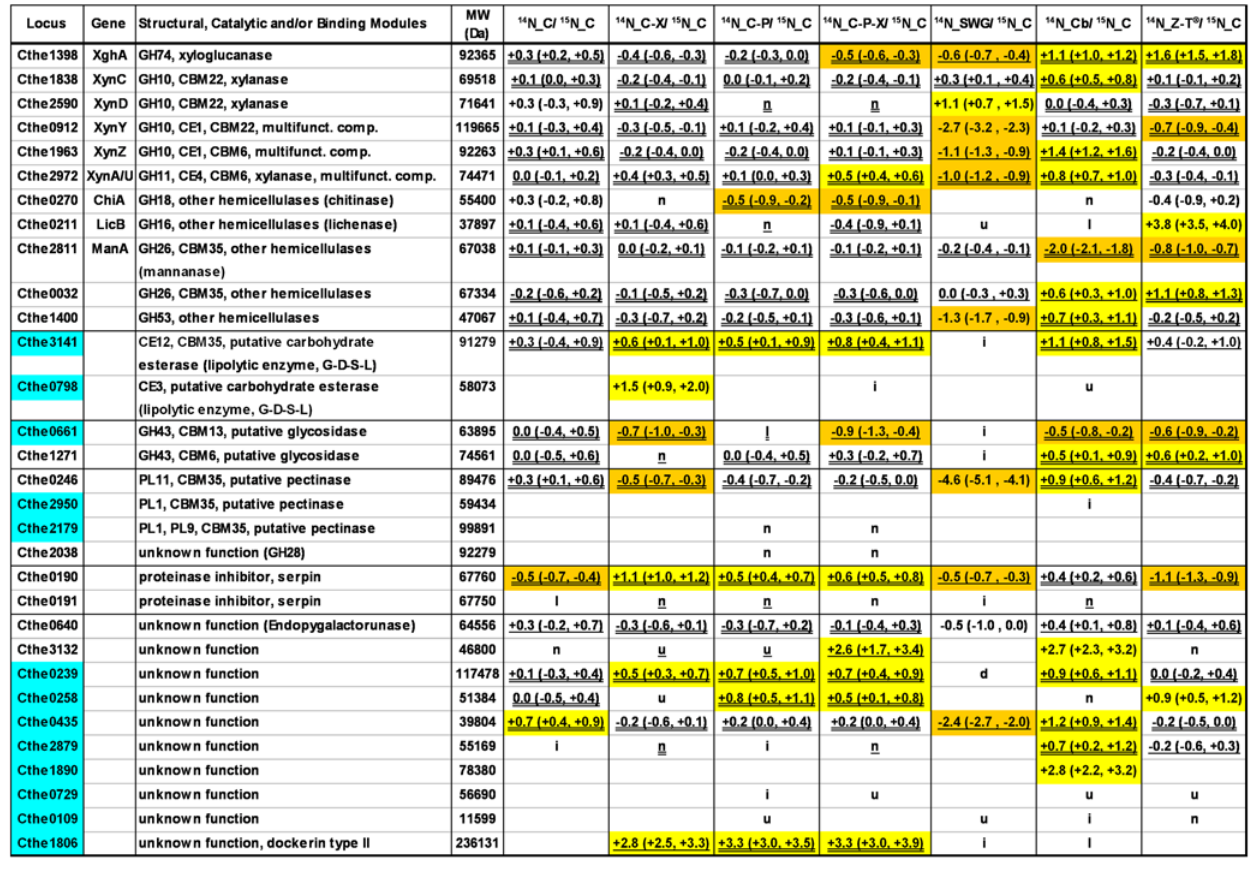
Figure 6. Quantitative changes in Clostridiumthermocellum cellulosome composition in response to carbon substrate – Part II. Quantitative data shown is combined from two biological and two technical replicates and expressed as Log 2 Ratio (LowerCI, UpperCI) of cellulosomal component X during growth on substrate Y over that in 15 N-labeled Cellulose cellulosome sample. Substrate key: C=Crystalline Cellulose (with 14 N or 15 N labeled nitrogen source), C-X=Cellulose-Xylan (5 g/L total in 3:2 weight ratio), C-P=Cellulose-Pectin (3:2), C-P-X=Cellulose-Pectin-Xylan (3:1:1), SWG=Pretreated Switchgrass (50% glucan, 8% xylan, 24% lignin), Cb=Cellobiose, Z-T=Z-Trim H (60% amorphous cellulose, 16% hemicellulose). Data was normalized to the scaffoldin CipA protein. Locus entries highlighted in Blue have not been observed experimentally prior to this study. Quantitation data highlighted in Yellow (increased expression in Substrate Y) and Orange (decreased expression in Substrate Y) satisfy the cut-off criteria. Criteria for differential expression was based on control comparison of 14 N- and 15 N-labeled cellulose cellulosome samples and were, (1) Log 2 Ratio should be . + 0.4 or ,2 0.4 and (2) Upper/Lower Confidence Intervals should exclude Log 2 Ratio=0. Structural, catalytic and/or binding module information was obtained from the following sources: http://pfam.sanger.ac.uk/; http://www.cazy.org/; http://genome.ornl.gov/microbial/ cthe/. Domain key: GH=Glycoside Hydrolase, CE=Carbohydrate Esterase, PL=Polysaccharide Lyase, CBM=Carbohydrate Binding Module. Legend key: MW=Molecular Weight, Log 2 Ratio (LowerCI, UpperCI) - protein was quantified in both biological replicates (BR), with overlapping confidence intervals; Blank - protein not identified or quantified; d - protein quantified in only one BR, but result indicates down-regulation (UpperCI , 0, Log 2 ratio ,2 0.4); D - protein quantified in both BR, but confidence intervals don’t overlap. Both confidence intervals indicate down- regulation (UpperCI , 0, Log 2 ratio ,2 0.4); i - identified in one BR, but no quantification result; I - identified in both BR, but no quantification result; n - protein quantified in only one BR, with result indicating no change in expression ( 2 0.4 , Log 2 ratio , + 0.4); N - protein quantified in both BR, but confidence intervals don’t overlap. Both confidence intervals indicate no change in expression ( 2 0.4 , Log 2 ratio , + 0.4); u - protein quantified in only one BR, but result indicates up-regulation (LowerCI . 0, Log 2 ratio . + 0.4); U - protein quantified in both BR, but confidence intervals don’t overlap. Both confidence intervals indicate up-regulation (LowerCI . 0, Log 2 ratio . + 0.4); A double underscore indicates that the protein was identified in both 14 N and 15 N forms in both BR; A single underscore indicates that the protein was identified in both 14 N and 15 N forms in only one BR; No underscore indicates that we did not identify both 14 N and 15 N forms in either BR. protein expression analysis and to determine criteria for differential expression. Based on this comparison, proteins with their relative log 2 abundance ratios greater than 0.4 or less than 2 0.4 and confidence intervals excluding 0 were considered as significantly differentially expressed.